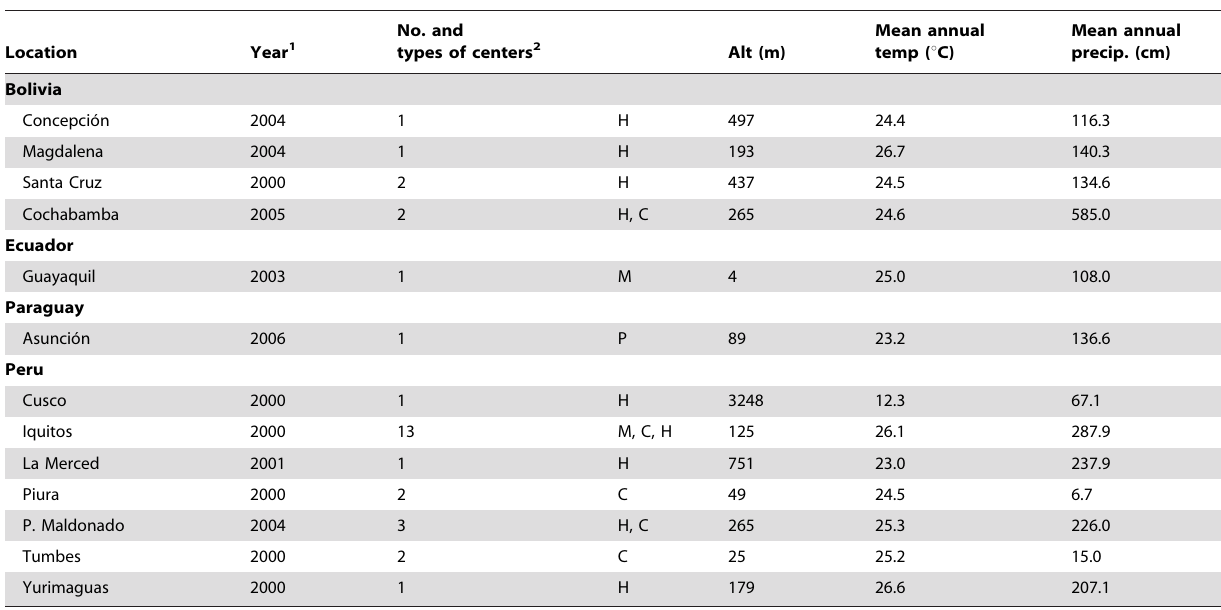
Table 1. Febrile illness surveillance study